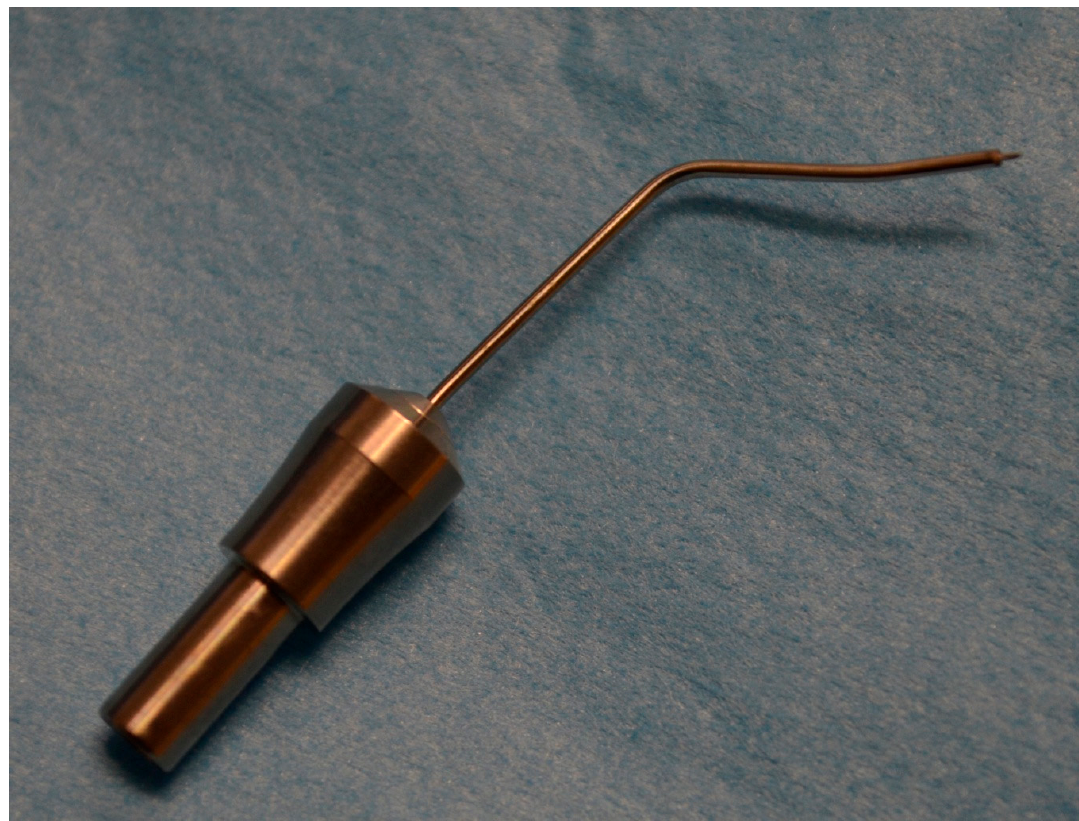
Figure 3. High Frequency Diathermy Probe (HFDS).